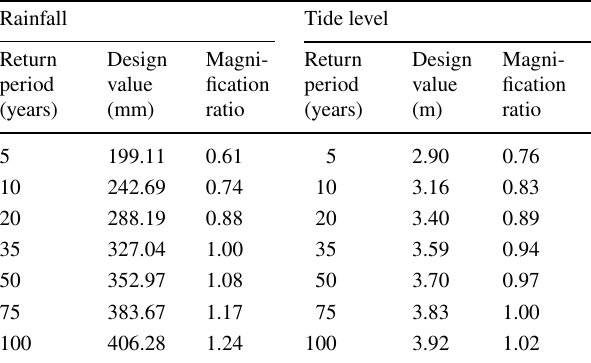
Table 1 Magnification ratios obtained by the same ratio method